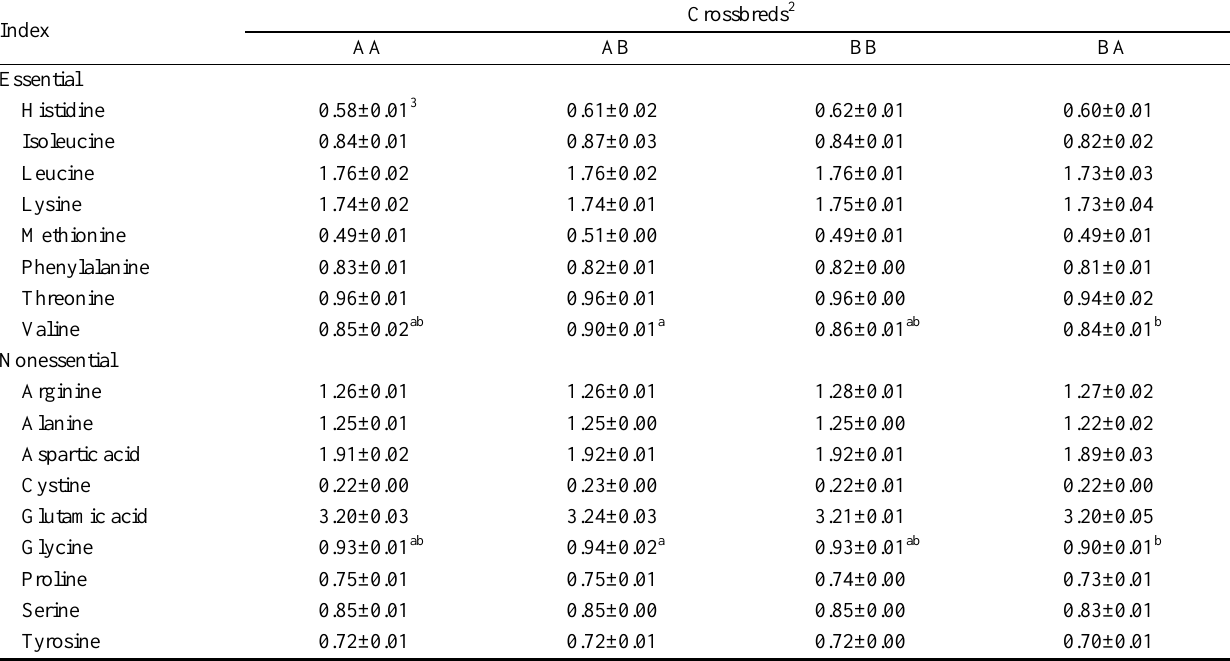
Table 10. Amino acid composition (%) of breast meat of commercial Korean native ducks